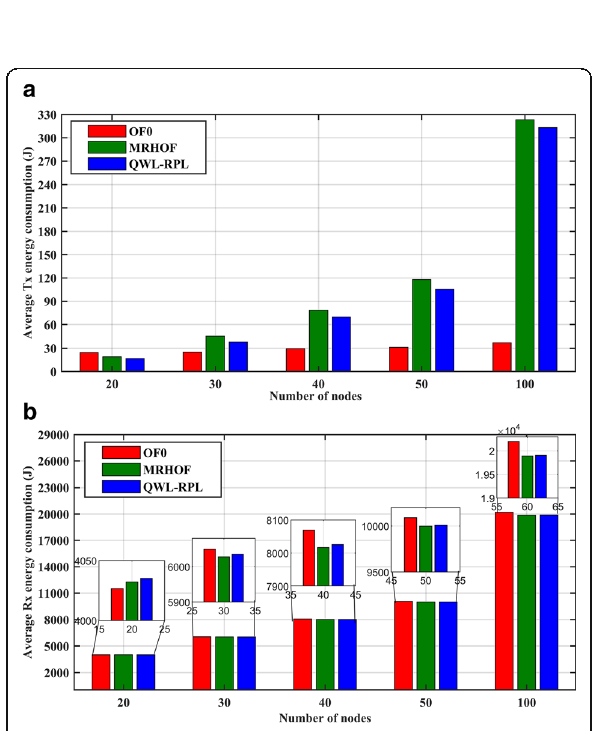
Fig. 19 Simulation analysis for the scenario II for a average Tx energy (J) and b average Rx energy versus number of